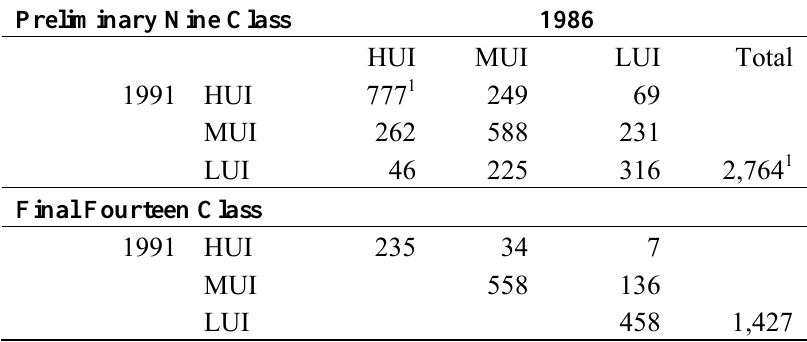
Table 2. Change in urban land cover class area (km 2 ) between 1986 and 1991 for the preliminary (hybrid classification approaches applied) and final (landscape trajectory post-classification rules applied)